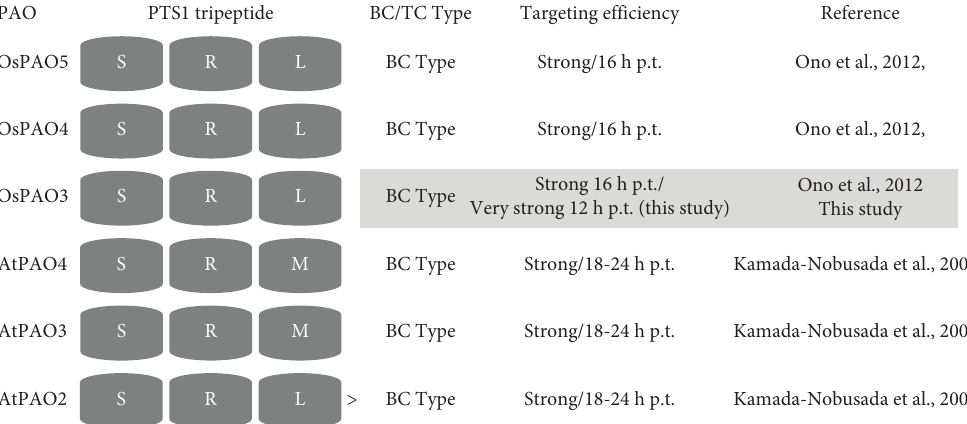
Figure 3: Te fgure shows the comparative information of A. thaliana and O. sativa peroxisomal PAOs. Te grey boxes represent the PTS1 tripeptide. Te greater sign ( > ) indicates the C-terminal end of the peptide. BC, back conversion; TC, terminal catabolism; p.t., post- transformation. Te last column shows the literature reference. Except for OsPAO3, others have not yet been verifed at 12h